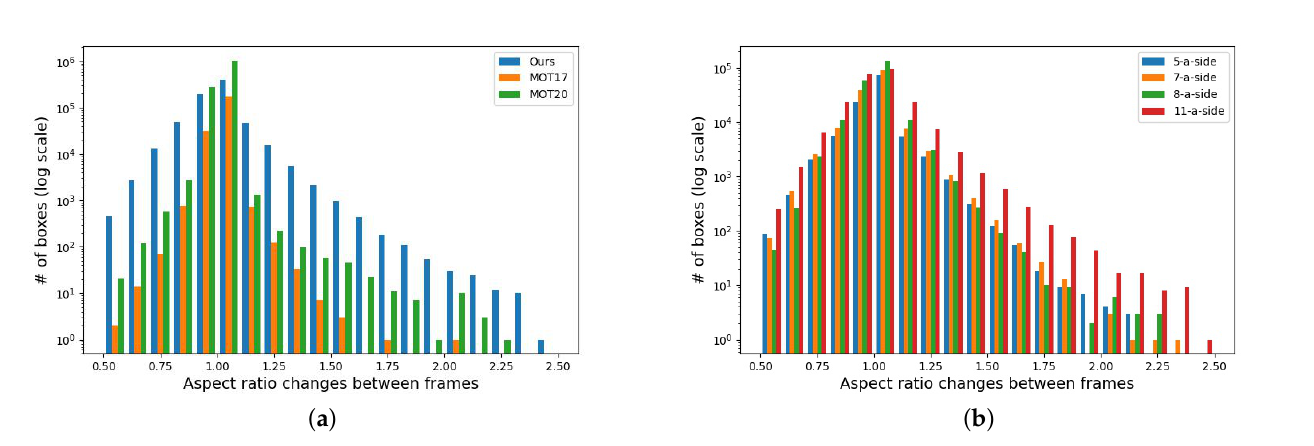
Figure 4. These two subfigures show aspect ratio of bounding boxes between two consecutive annotated frames. ( a ) Comparison between our dataset and MOTChallenge dataset, both datasets are open source adn recorded by single cameras. ( b ) Comparison between subdatasets of our datasets.